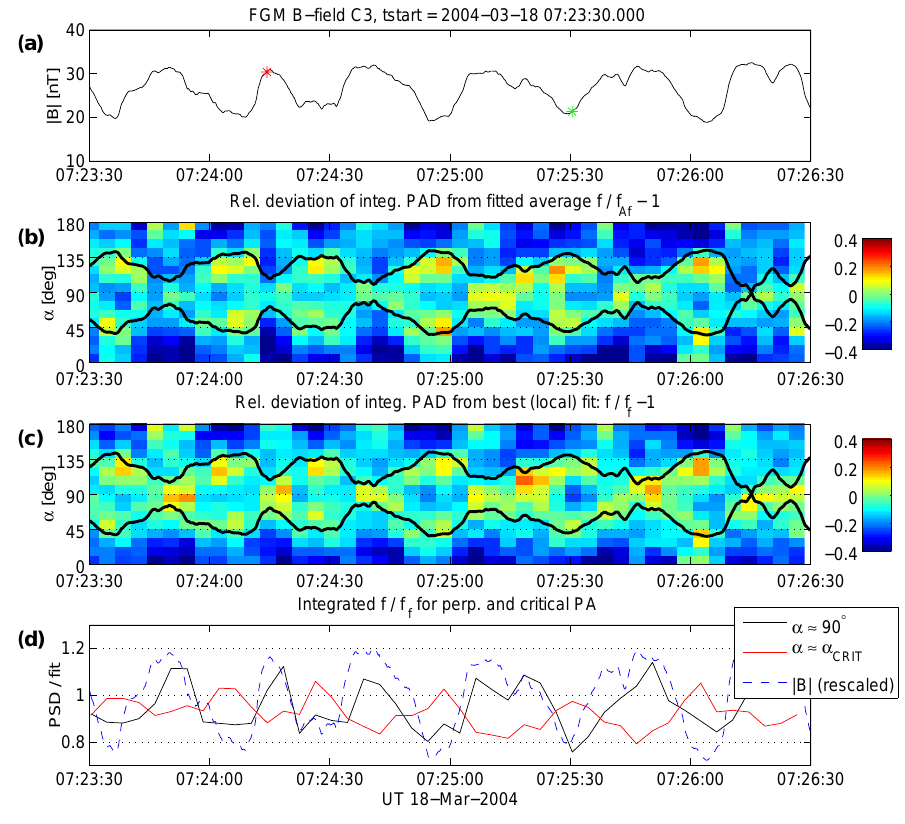
Fig. 4. Pitch angle distribution spectrograms integrated in energy (10eV–1keV). Top to bottom: (a) magnetic field magnitude. (b) Relative deviation of measured 2-D distribution from the fitted background f Af (linear color). Overplotted black line is the critical angle α c . (c) Rel- ative deviation of measured 2-D distribution from the local fit f f (linear color). (d) The pitch angle distribution normalized by local fit f/f f integrated over near-perpendicular pitch angles (black line) and pitch angles near α c (red line). Rescaled magnetic field magnitude | B | is overplotted (blue dashed